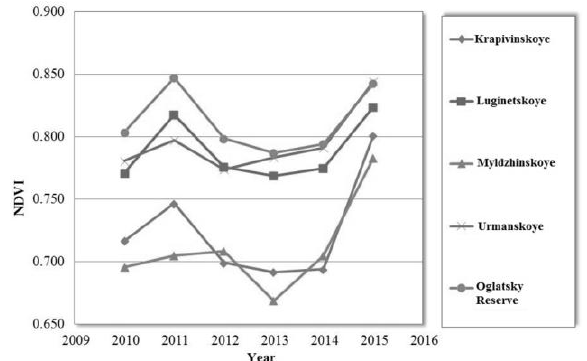
Figure 2. Analysis of the normalized difference vegetation index